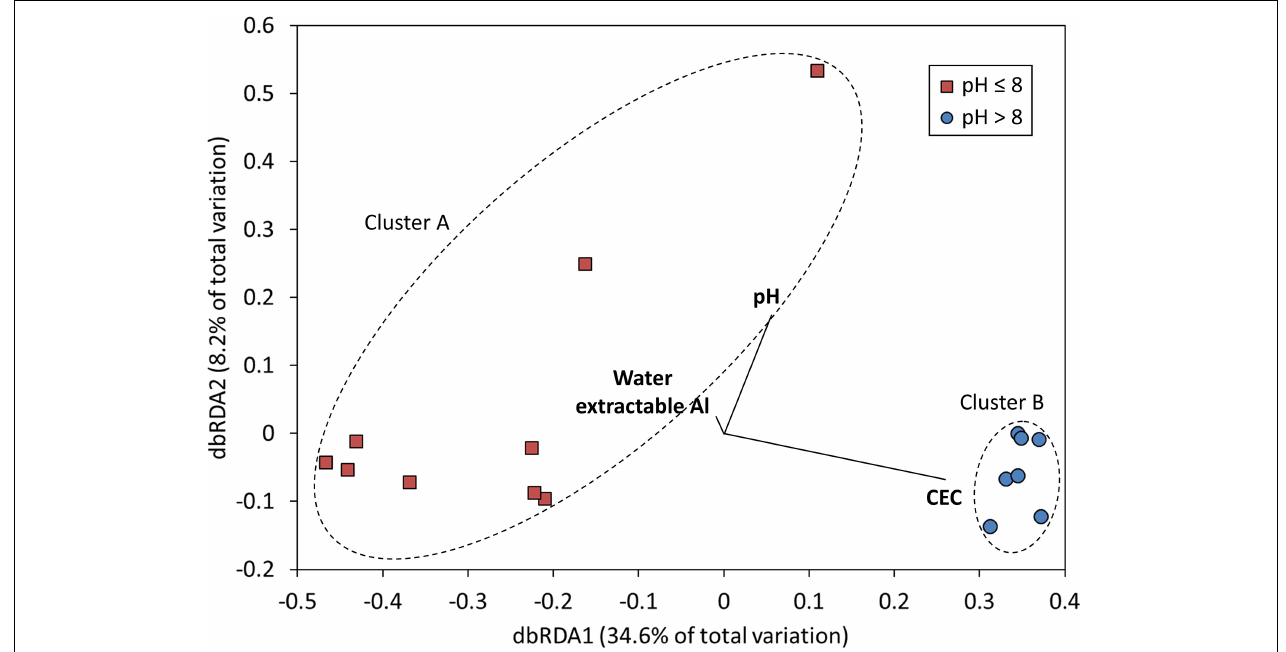
FIGURE 3 | Ordination plot (DistLM results, as visualized by dbRDA) showing relationships between measured geochemical variables and microbial community composition in Western Australian salt lakes. Each point represents microbial community composition in one lake. Lakes are split by sediment pH: Cluster A (PERMANOVA) grouped sites with pH 8 or below (marked with red squares) and Cluster B (PERMANOVA) grouped sites with pH above 8 (marked with blue circles). Dashed lines provide a visual guide to sites grouped within each cluster. Vectors for geochemical variables (in bold) with significant associations with microbial community composition are shown here; variables with non-significant associations were